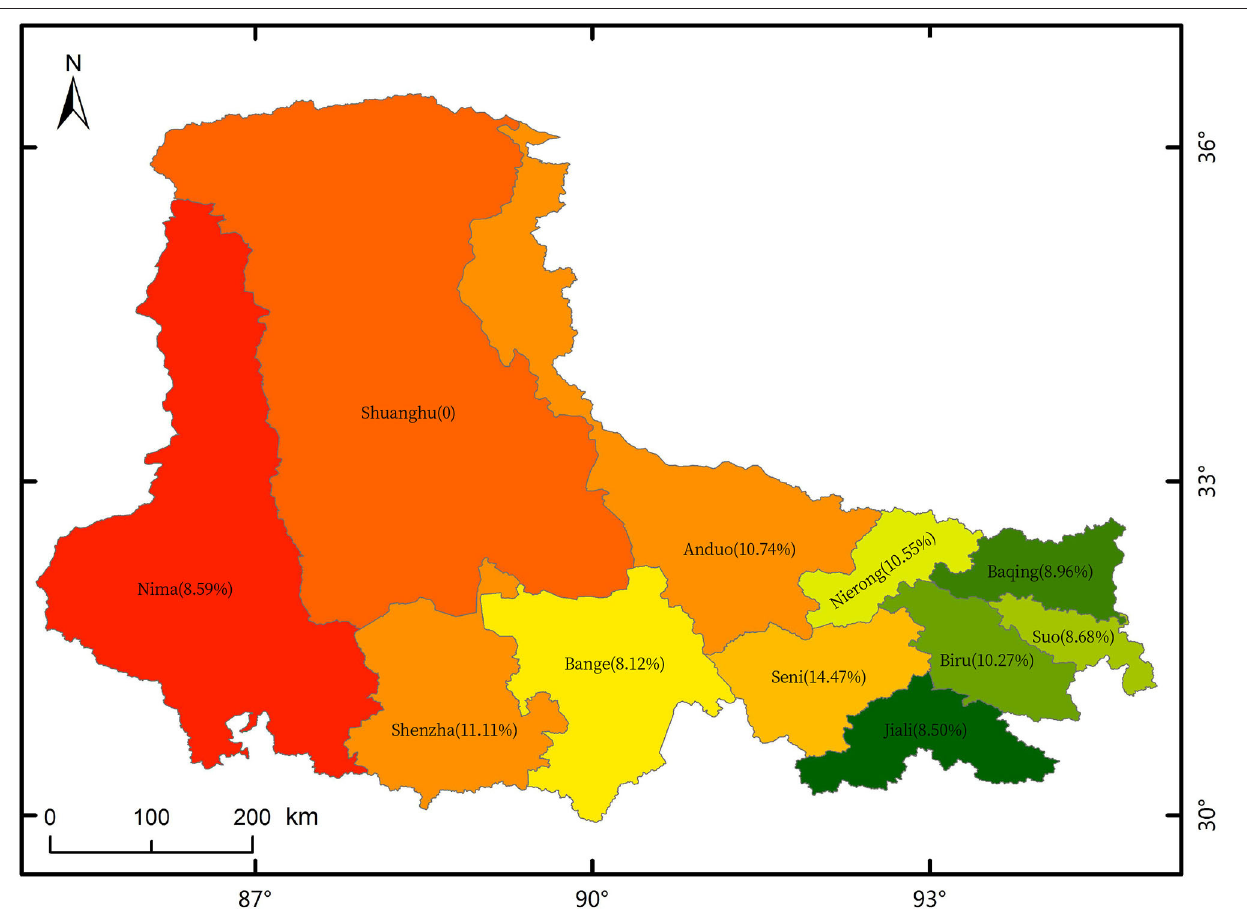
FIGURE 2 | Percentages of participants from 10 different